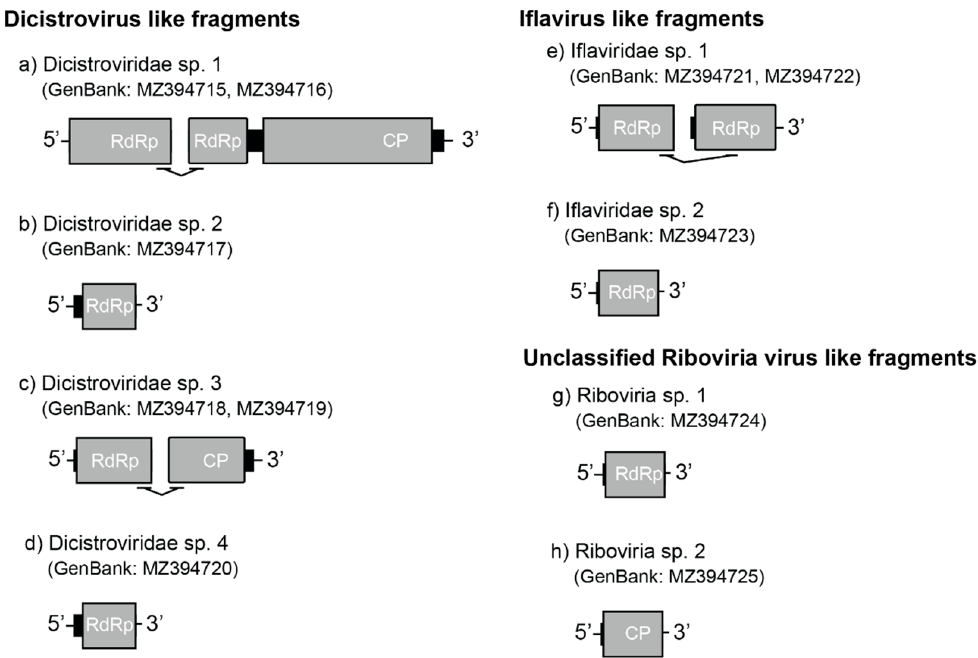
Figure 2. The conserved domain of virus-like fragments in the A . gracilipes transcriptome. Grey rectangles represent ORFs. RdRp: RNA-dependent RNA polymerase, CP: capsid protein.